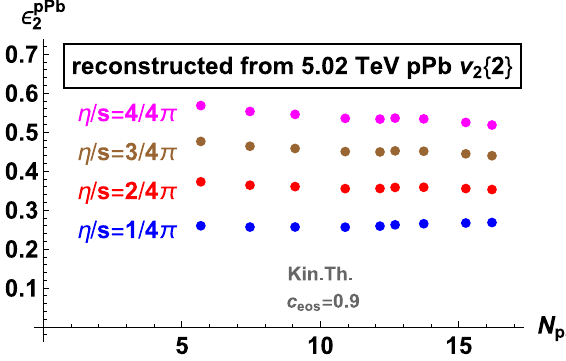
Fig. 16 The eccentricities (cid:17) 2 reconstructed for pPb CMS